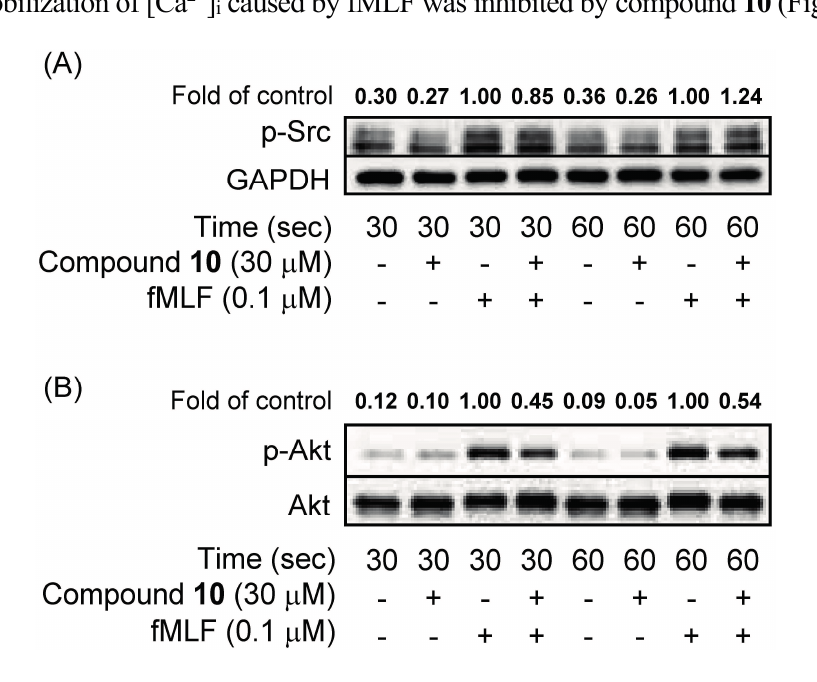
Figure 2. Compound 10 inhibits phosphorylation of Akt, but not Src, in fMLF-activated human neutrophils. Quantitation of the p-Scr/GADPH ( A ) and p-Akt/Akt ( B ) ratios is shown. Representative images from one of three experiments are shown.